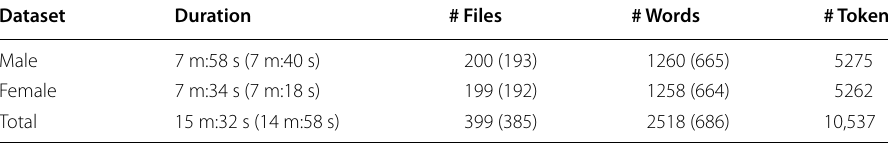
Actual duration and number of files after discard are shown between parentheses, as well as the number of unique words